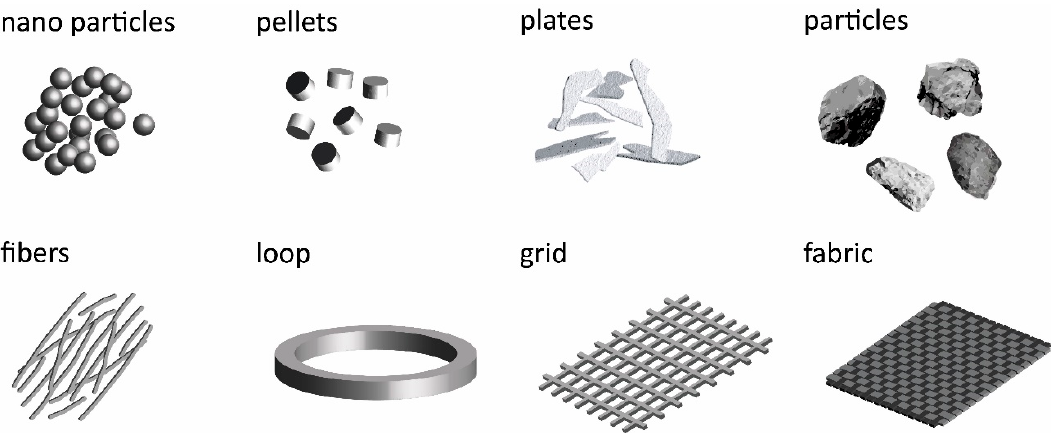
Figure 2. Different designs and materials used as susceptors (not to scale).